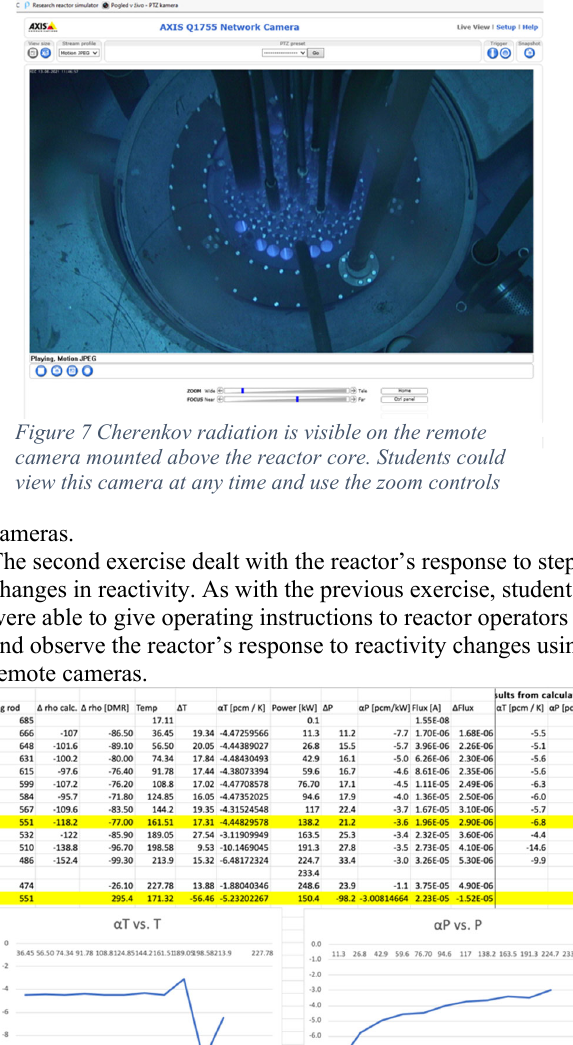
Figure 9 The shared spreadsheet was edited by multiple students with dedicated roles simultaneously. The students were entering the rod positions, changes in reactivity and temperatures and calculating the temperature and power reactivity coefficients (plots on the bottom part).